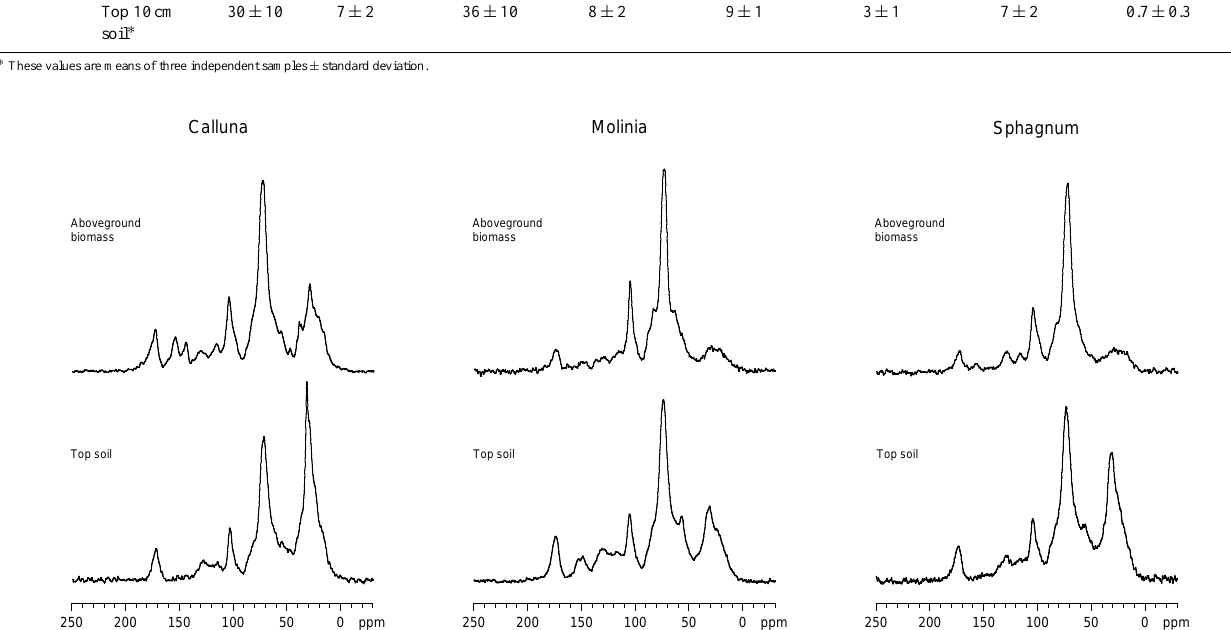
Figure 2. 13 C CP MAS NMR spectra of the aboveground biomass of the dominant plant species and soil.